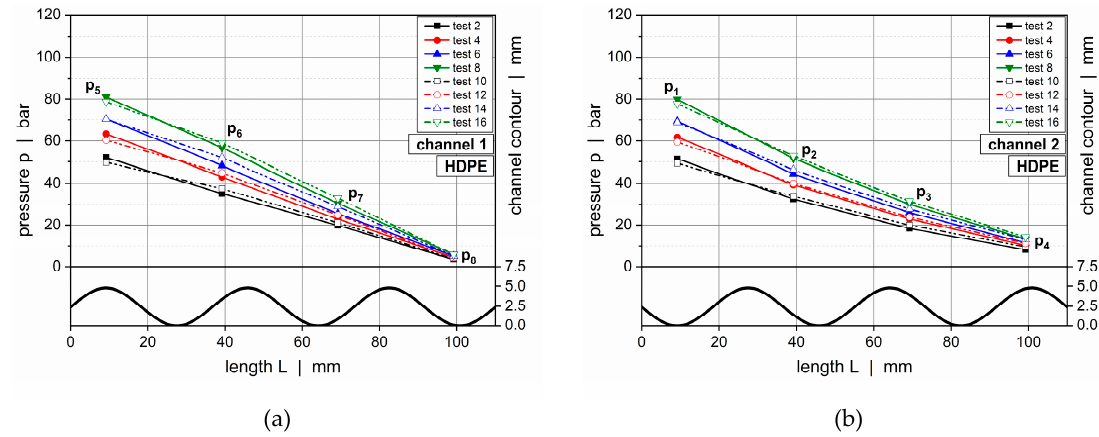
Figure 18. Comparison of axial pressure profiles along channel 1 ( a ) and channel 2 ( b ) for test configurations 1 and 2.